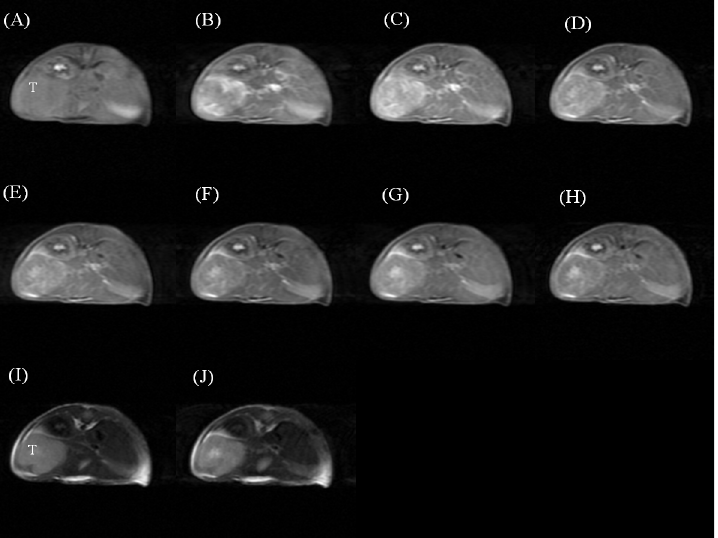
Fig 3. Dynamic contrast enhanced T1-weighted images before (A), 0.5 (B), 5 (C), 10 (D), 15 (E), 20 (F), 25 (G), and 30 (H) min after intravenous administration of Gd-DTPA. And T2-weighted images before (I) and 30 min after (J) Gd-DTPA administration. T,